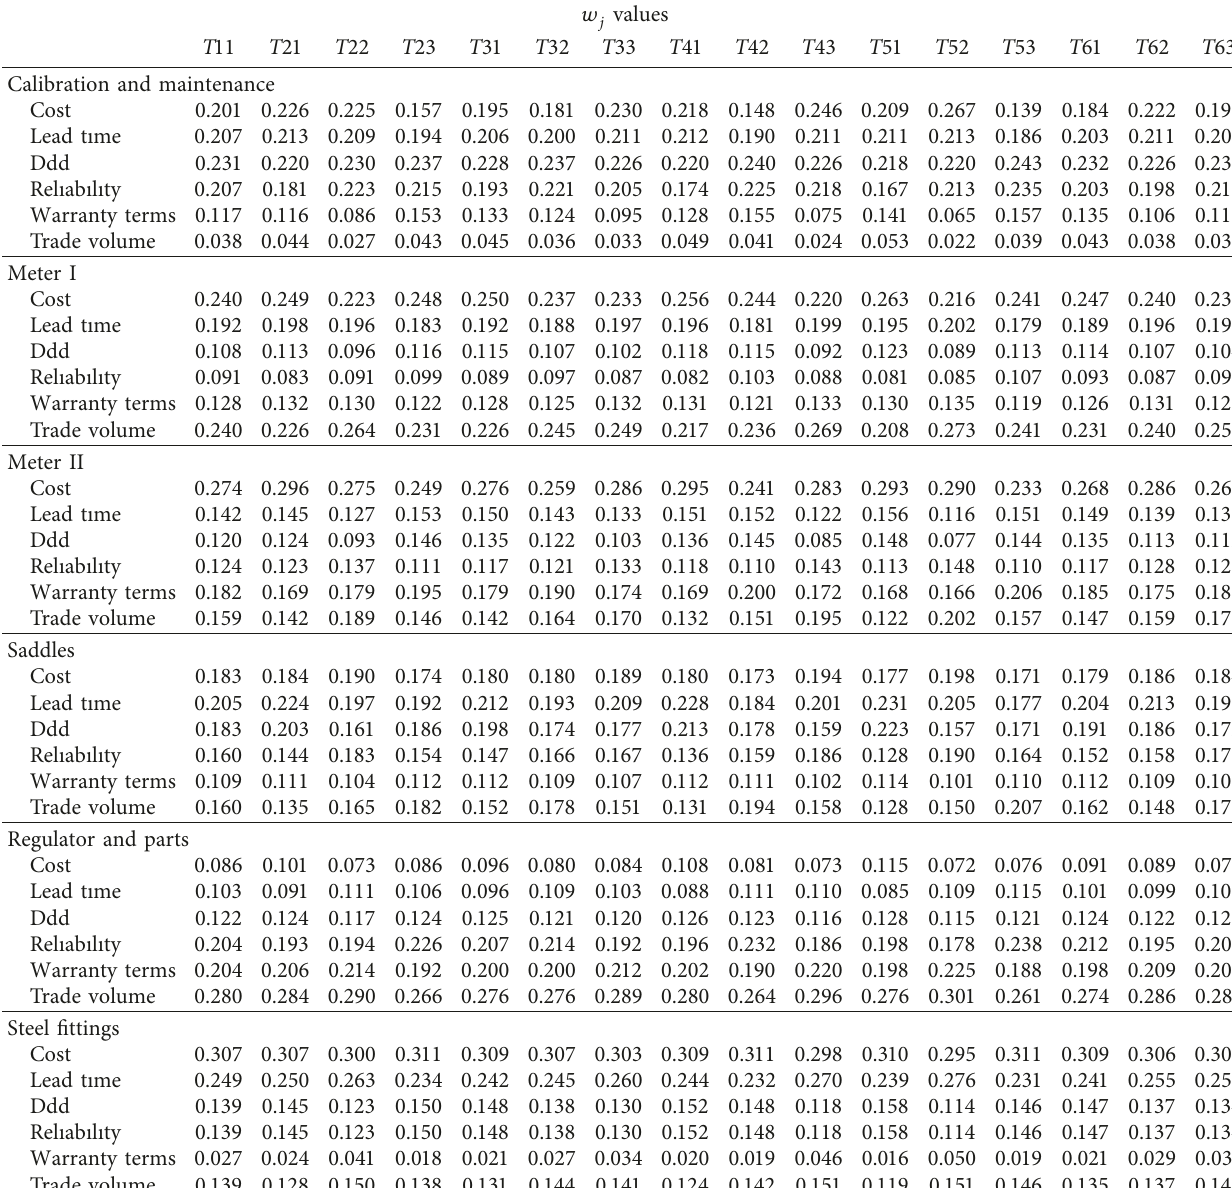
Table 14: Calculated w k values for each item group in sensitivity